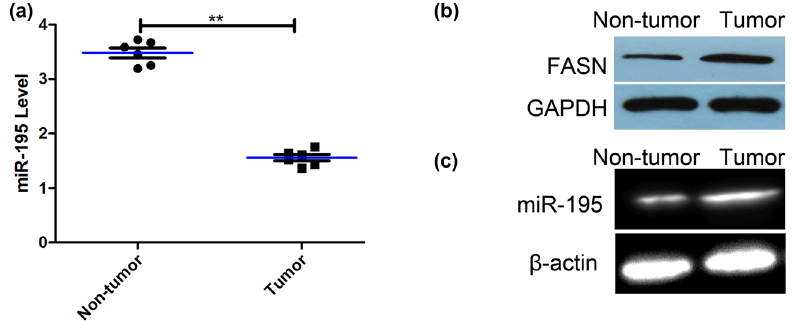
Figure 1: The expression of miR - 195 and its methylation level in the osteosarcoma tissues. ( a ) The expression of miR - 195 of fresh osteosarcoma tissues was signi fi cantly lower than that of fresh normal bone tissue ( n = 6; p < 0.001 ) . The error bar represents the standard variation of the miR - 195 levels in patients with or without osteosarcoma. ( b ) The western blot assay showed that the expression of FASN of fresh osteosarcoma tissues was signi fi cantly higher than that of fresh normal bone tissues ( n = 6 ) . ( c ) MSP assay showed that the methylation levels of promoter regions of miR - 195 in osteosarcoma tissues were signi fi cantly higher than that in fresh normal bone tissues ( n = 6 ) . * p < 0.05, ** p < 0.01, n =